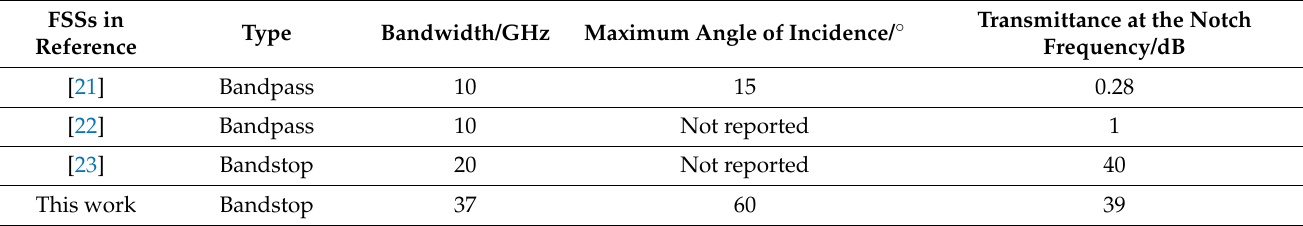
Table 1. Comparison of the proposed FSS with the reported FSSs operating beyond 100